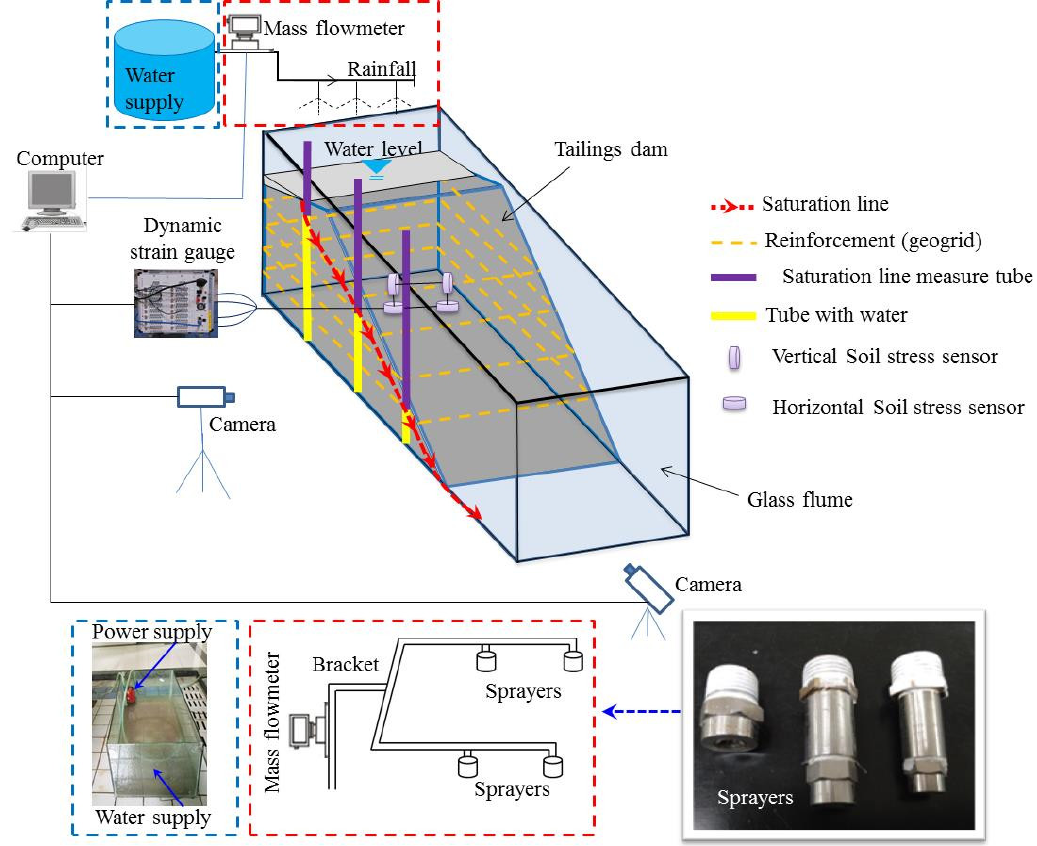
Figure 1. Tailings dam overtopping failure model test system.